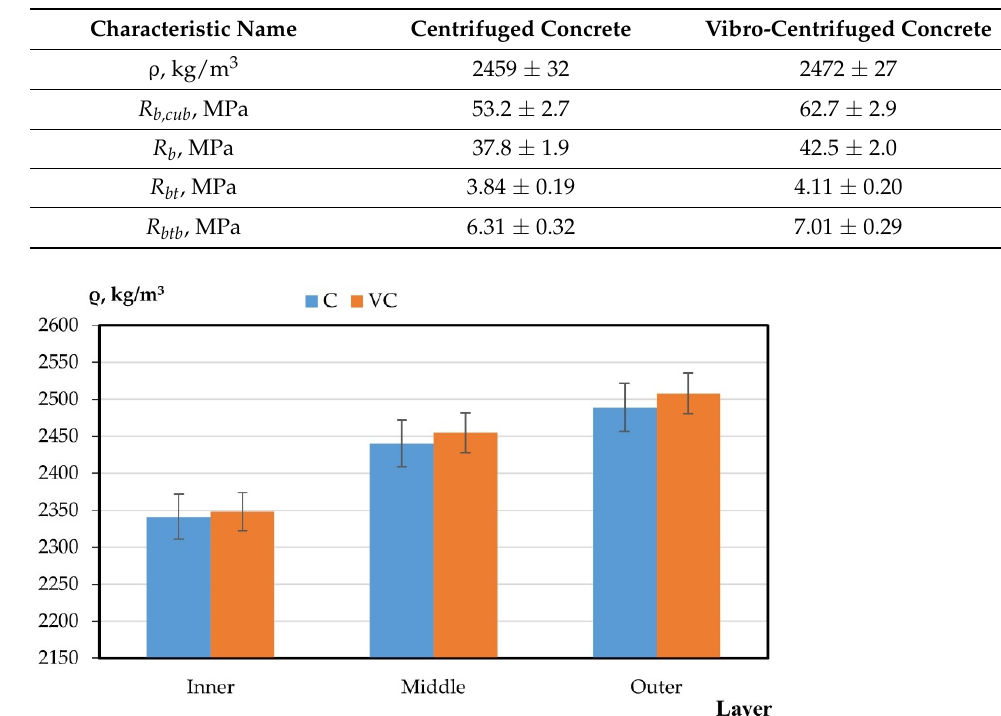
Figure 3. Change in density by layers (C—centrifuged concrete, VC—vibrocentrifuged concrete).